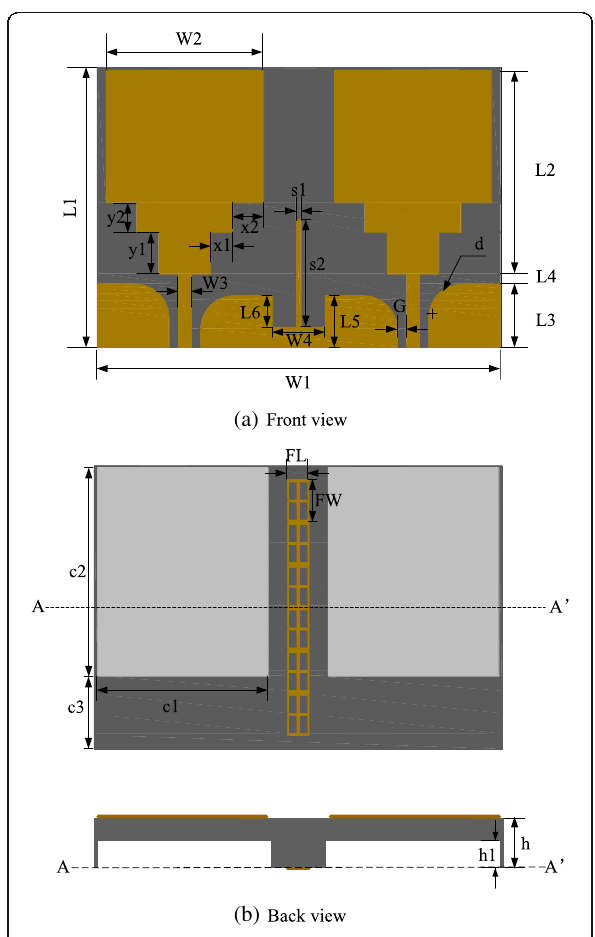
Fig. 1 Configuration of the UWB-MIMO antenna. a Front view.